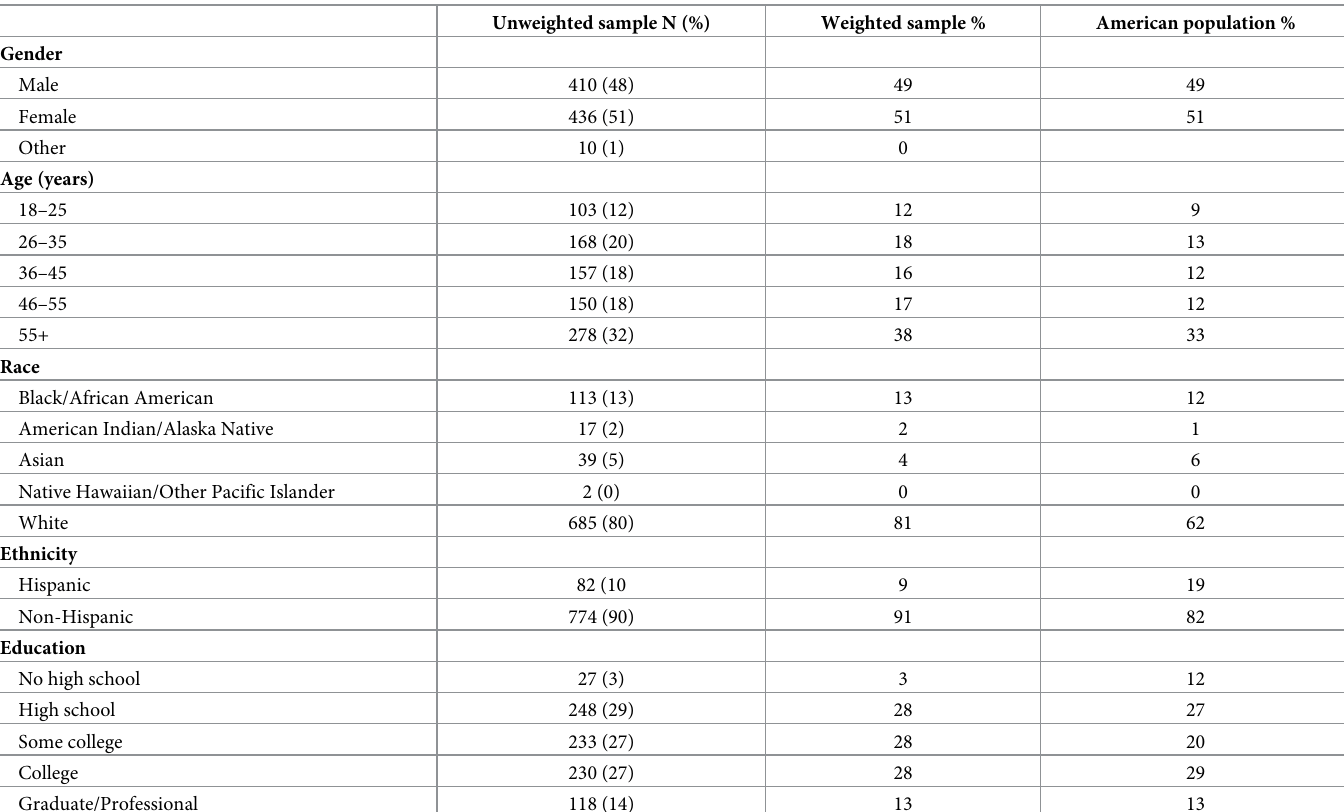
Table 1. Demographics of the